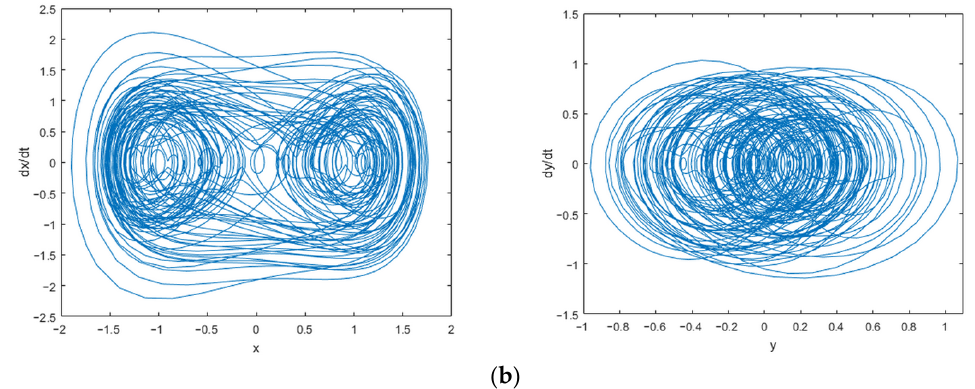
Figure 5. Phase diagrams of the vibration absorber (on the left side) and the main system (on the right side) at different excitation amplitudes. ( a ) ω = 2, p = 0.15; ( b ) ω = 2, p = 0.5.